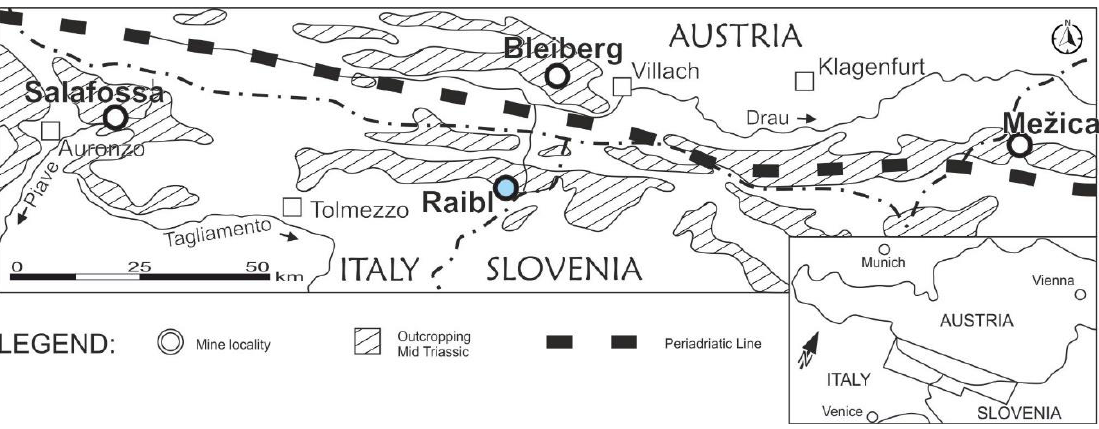
Figure 1. Location of the four main Pb-Zn carbonate-hosted ore deposits in the SE Alps domain, redrawn from Brigo et al. [23]. The strata-bound Mid-Upper Triassic Pb-Zn Raibl ore deposit is nestled in a 1000 m thick Ladinian carbonate massif (“Sciliar/Schlern Formation”). The Sciliar/Schlern